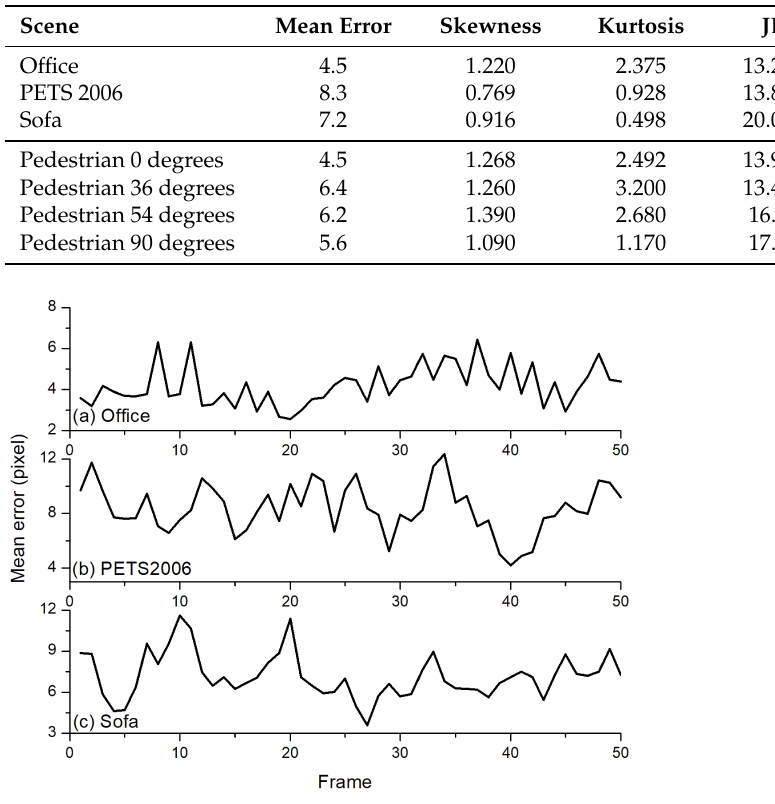
Figure 14. Mean fit error (in pixels) for each frame in the ( a ) Office, ( b ) PETS2006, and ( c ) Sofa scenes.